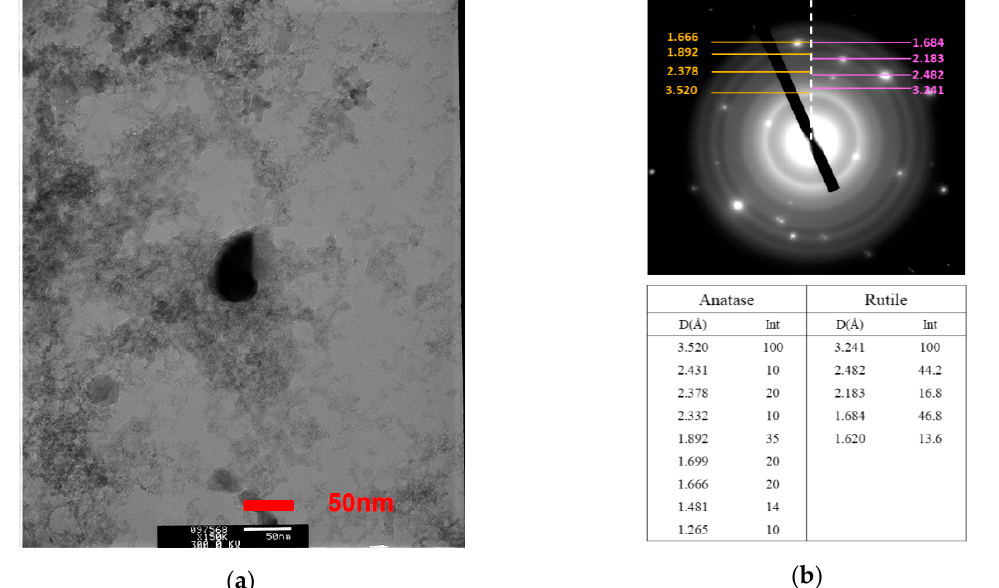
Figure 2. A typical TEM micrograph and corresponding diffraction pattern of a sample with C 2 H 2 800 sccm, C 2 H 2 /O 2 = 1:5. ( a ) Micrograph; ( b )diffraction pattern.